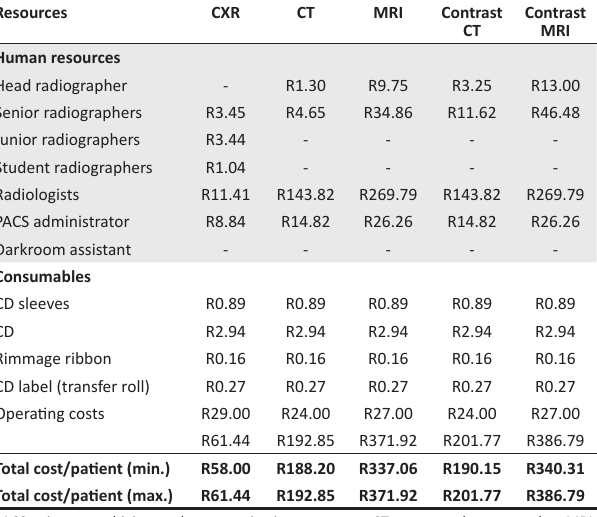
TABLE 4: Imaging costs for PACS.